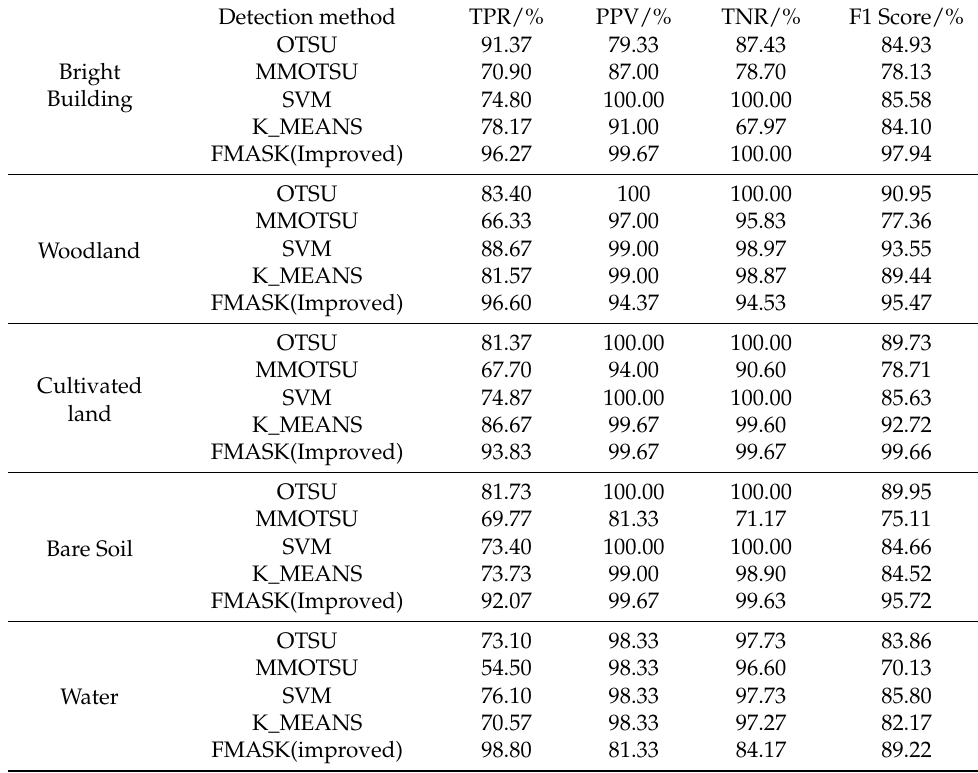
Table 2. Comparison of accuracy evaluation of cloud detection results with different